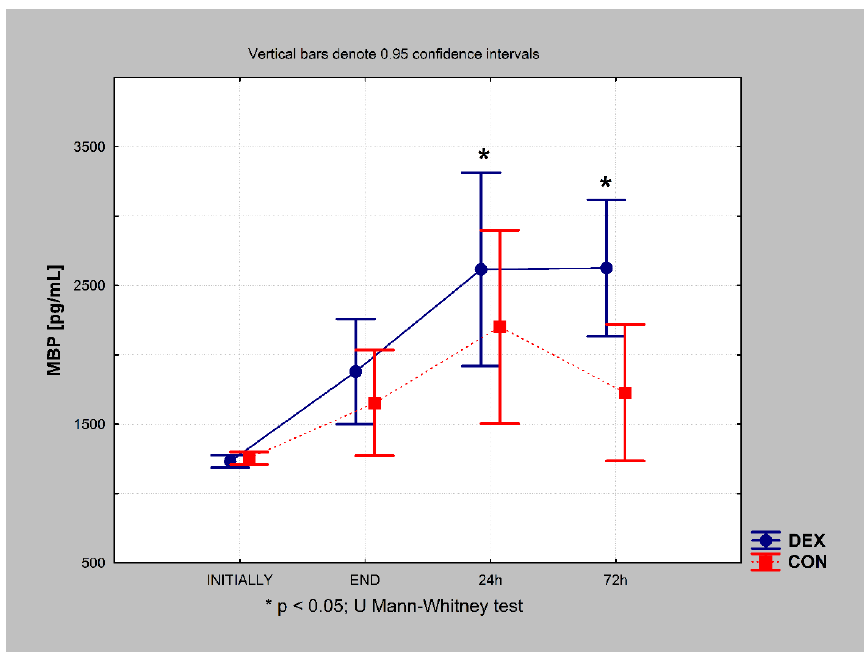
Figure 2. Myelin basic protein (MBP) concentrations in the DEX and CON groups at different time points during the study. CON, control; DEX, dexmedetomidine.